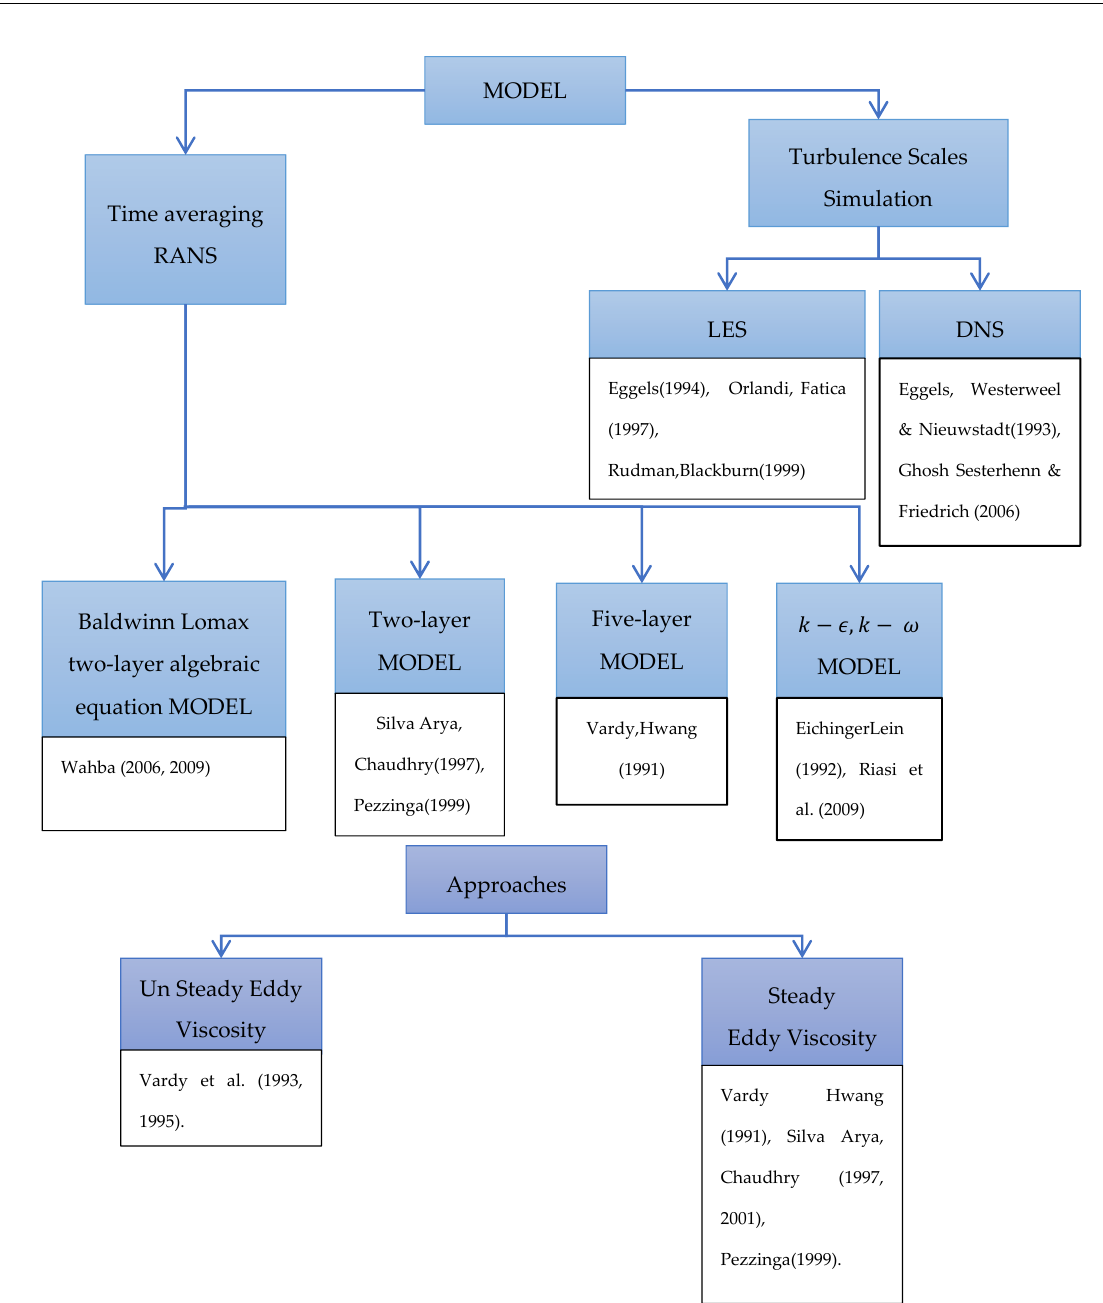
Figure 16. Turbulence models available for transient analysis.